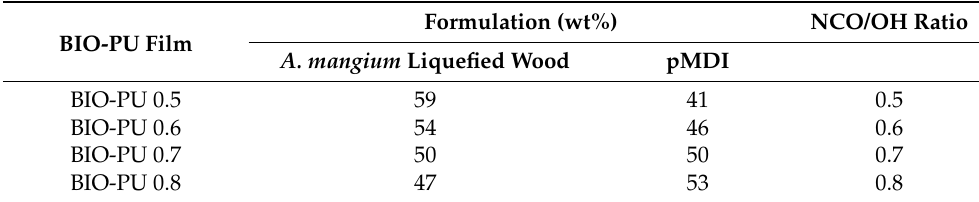
Table 1. Ingredients for BIO-PU film